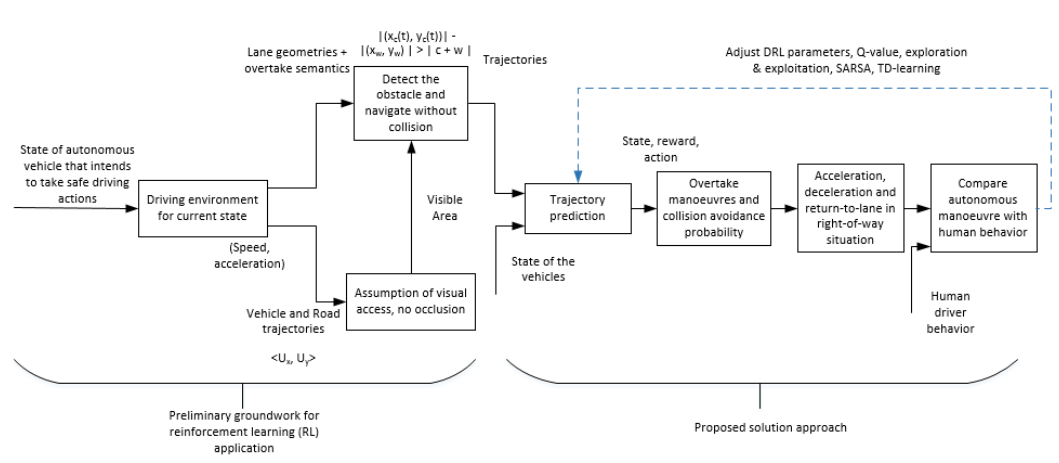
Figure 6. Proposed solution